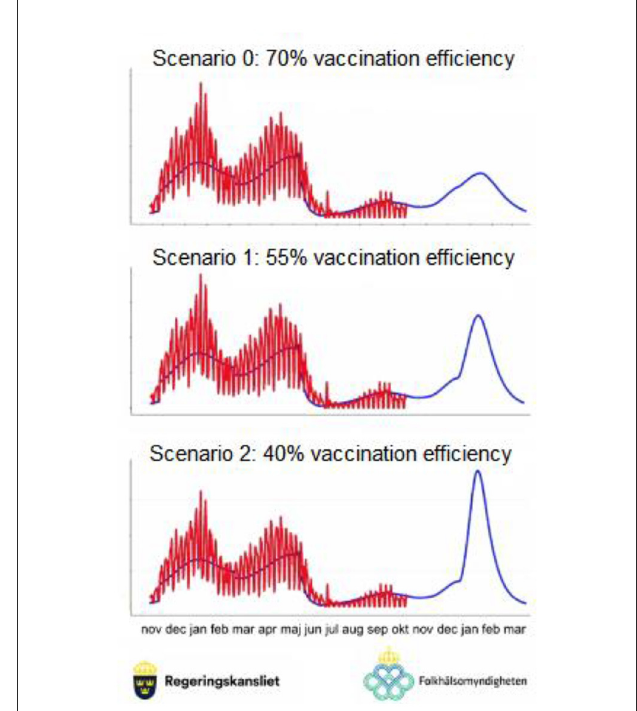
FIGURE3 Swedish Government infection projections (joint press conference on Dec 21, 2021, together with the Swedish Public Health Agency).